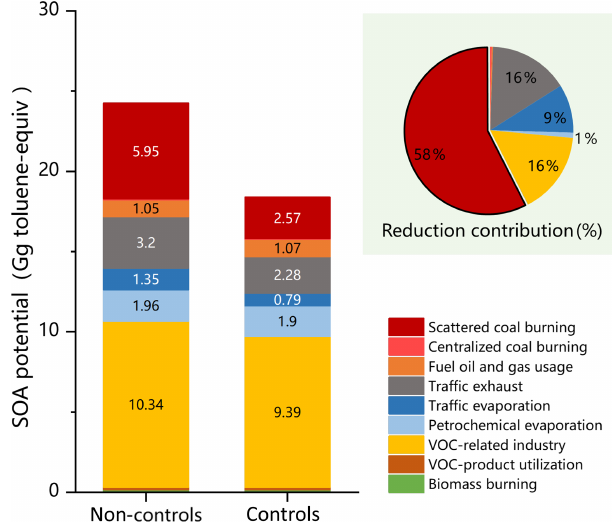
Figure 9. SOAP-weighted mass contributions of different sources and their contribution to total reduction (%) based on emission in-